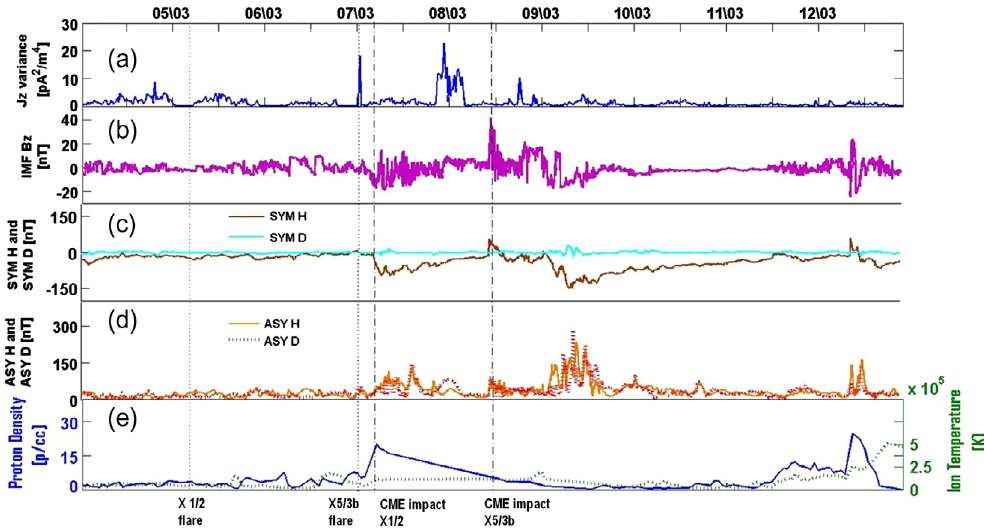
Figure 7. Same as in Figure 4, for 7–8th March 2012,